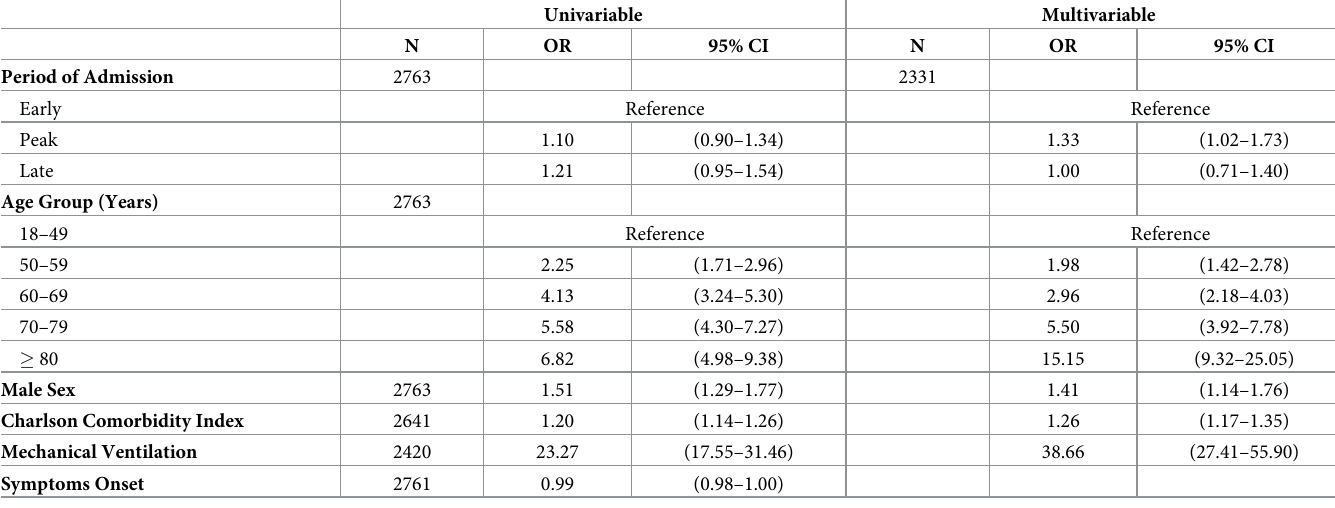
Table 2. Variables associated with mortality in univariate and multivariate